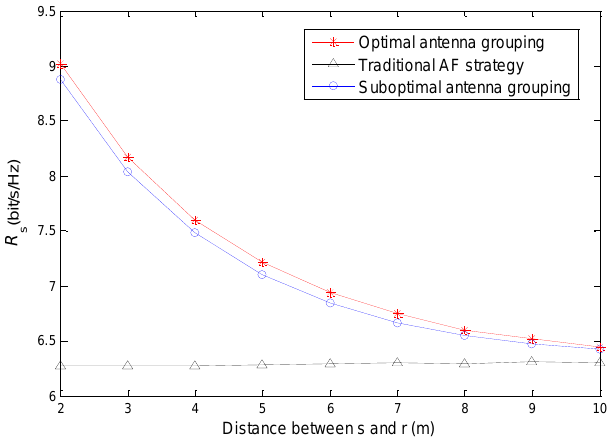
Figure 3. Relationship between relay’s position and secrecy rate.